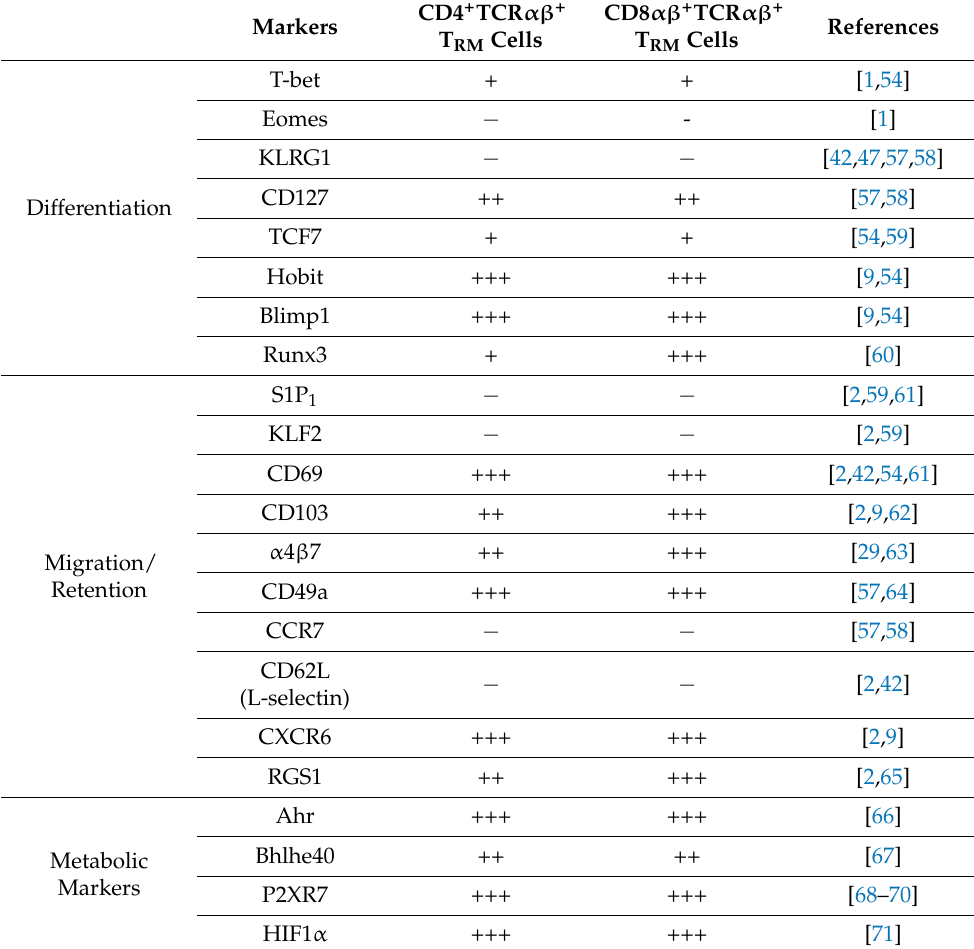
Table 1. Phenotypic signatures of conventional intestinal T RM